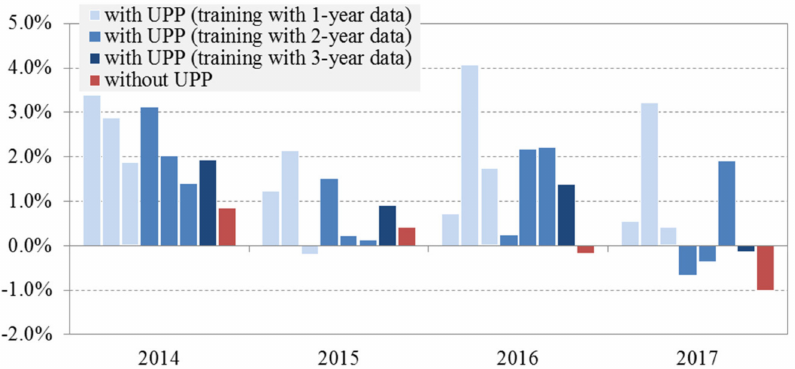
Figure 13. Annual financial income improvement rate in comparison to the persistence case for the simulated years with the forecast product as input. Red bars refer to the data presented also in red in Figure 12c. The optimized dispatching strategy is applied with and without the UPP, taking di ff erent training data sets into account, as explained in Figure